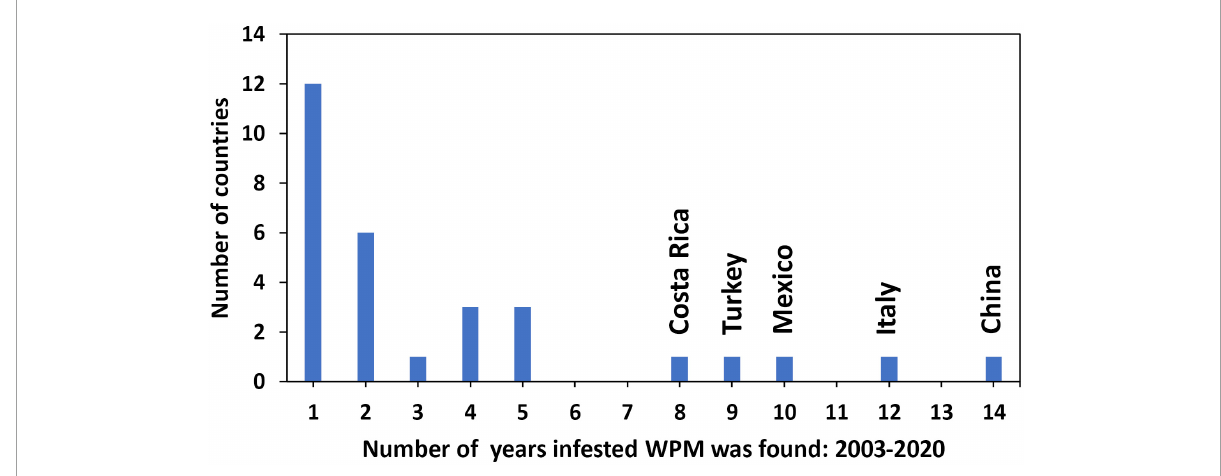
FIGURE5 Number of countries of origin from which wood borers were detected in WPM imported into the US by the number of years that borers were detected from individual countries during the period